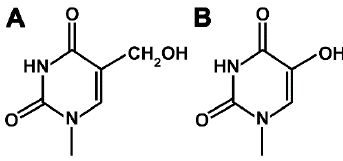
Figure 1. Structures of 5-hydroxymethyluracil (HMdU) ( A ) and 5-hydroxyuracil (HdU) ( B ).